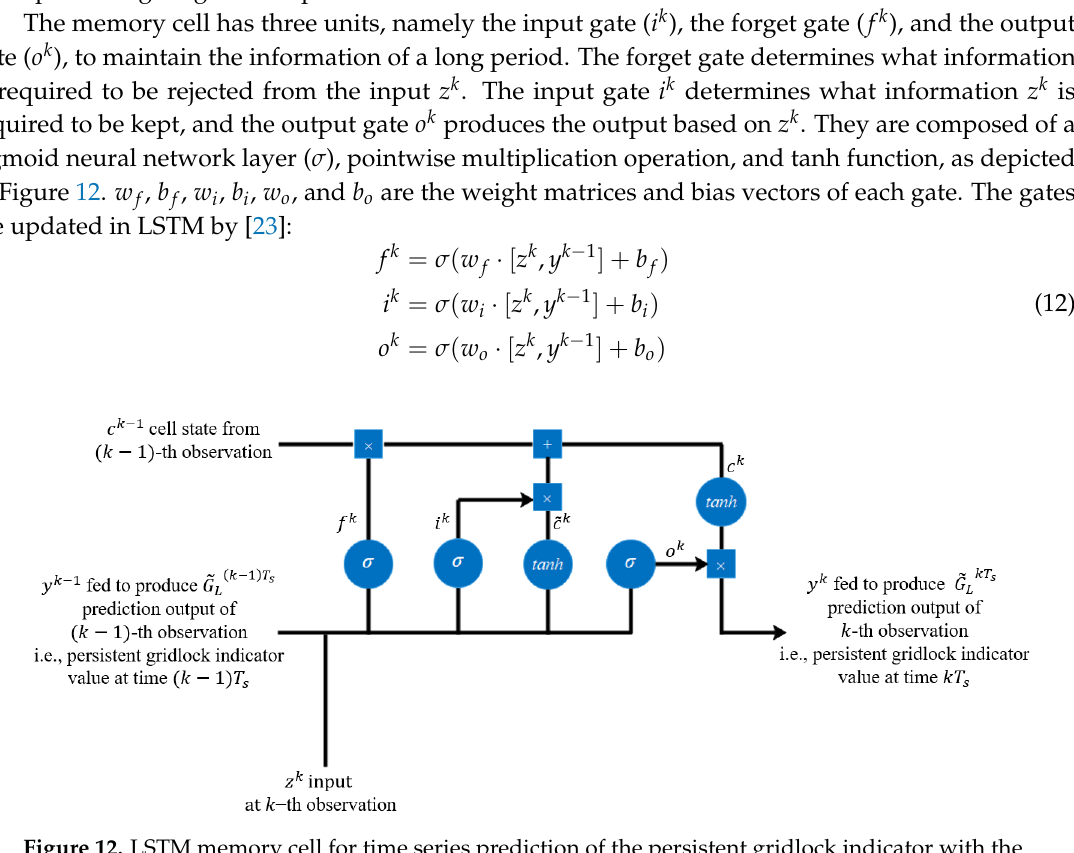
Figure 12. LSTM memory cell for time series prediction of the persistent gridlock indicator with the time sampling interval of T s